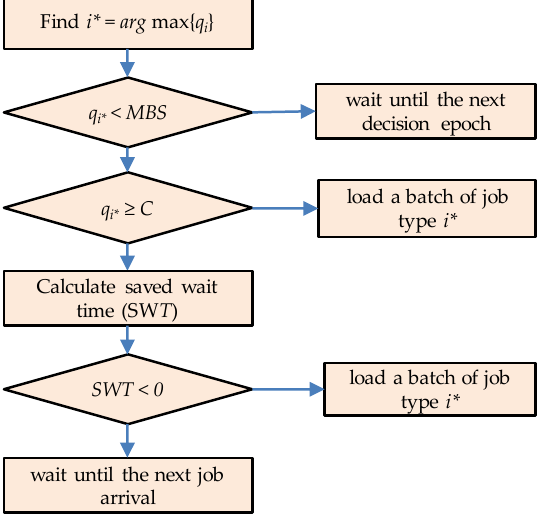
Figure 4. Decision procedure of look-upstream rule (LKUP). MBS, minimum batch size.